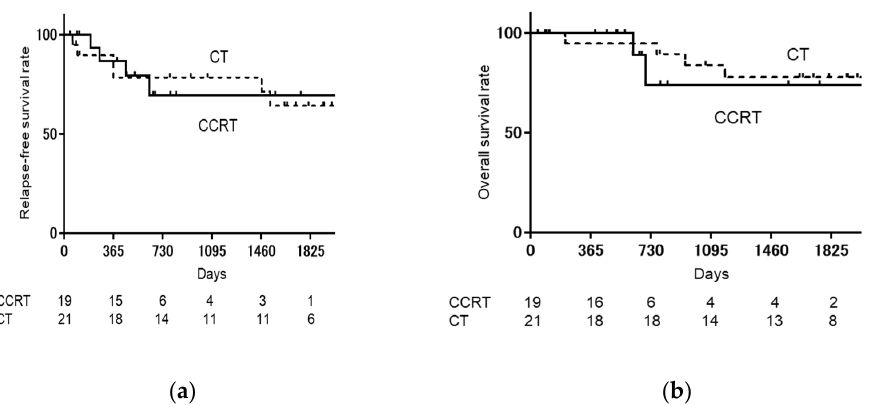
Figure 1. Kaplan–Meier analysis of relapse-free survival (RFS) and overall survival (OS). ( a ) Kaplan–Meier analysis of relapse-free survival (RFS); ( b ) Kaplan–Meier analysis of overall survival (OS). The CCRT group is compared with the CT group, and RFS (log-rank: p = 0.9751, HR: 1.020, 95%CI: 0.2885–3.605) and OS (log-rank: p = 0.6868, HR: 0.7266, 95%CI: 0.1233–4.281) are not significantly different. CCRT: concurrent chemoradiotherapy, CT: chemotherapy.